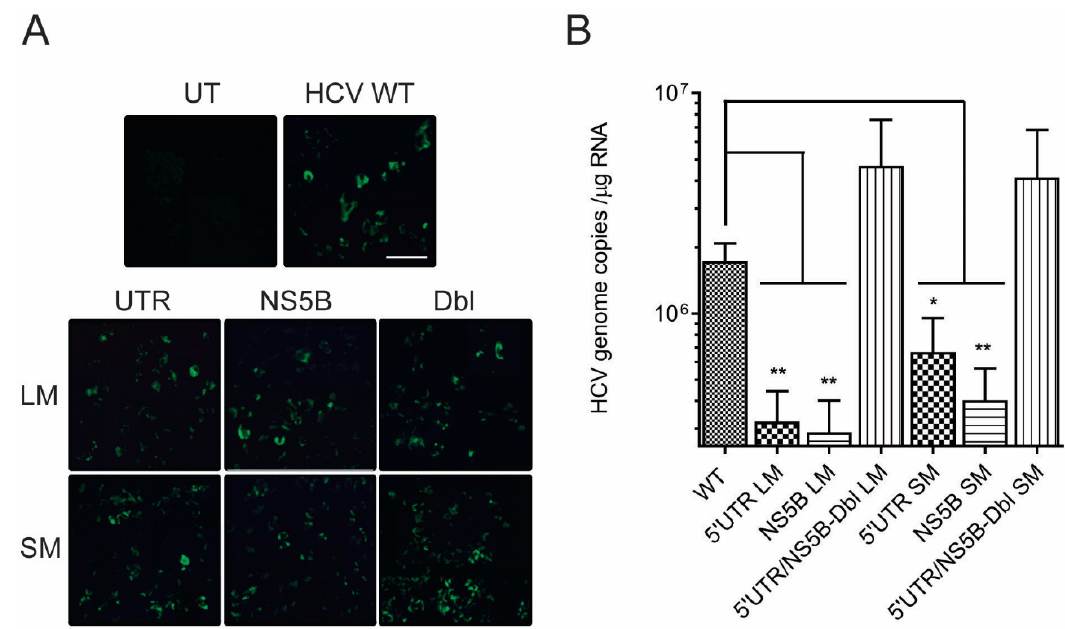
Figure 4. Disruption in the 5’UTR nt95–110:NS5B nt8528–8543 duplex reduces intracellular HCV RNA levels. ( A ) Huh-7.5 cells transfected with HCV genomic RNA (WT) or HCV genomic RNA containing mutations at 5’UTR nt 95–110 and NS5B nt 8528–8543 express NS5B antigen 24 h post-transfection. Scale bar = 50 µm. ( B ) Plots represent the average number of HCV RNA genome copies ± SE in 1 µ g of cellular RNA at 48 h post-transfection. p -values ≤ 0.05 (*) or ≤ 0.01 (**) were determined by the Student’s t -test and represent four or more independent experiments.